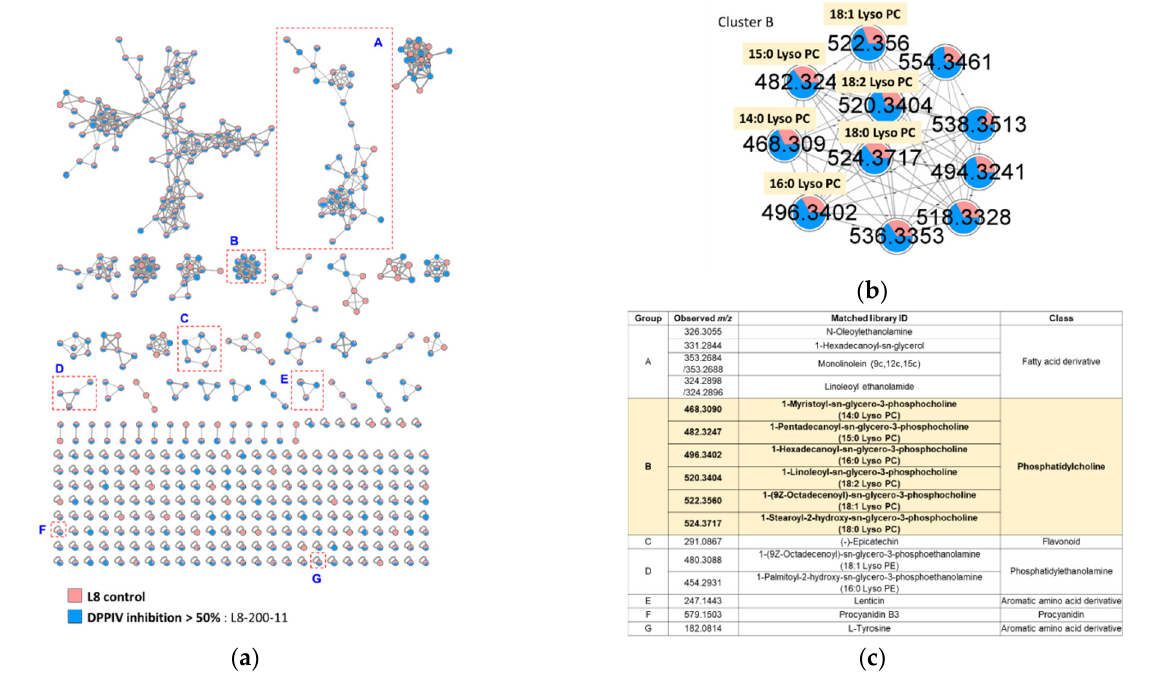
Figure 1. Feature-based molecular networking of lentil samples: ( a ) an entire molecular network of L8 control and L8-200-11 (most active sample); ( b ) targeted cluster annotation for the active lentil mutant lines extracts; ( c ) annotated molecular node by the comparison of Global Natural Product Social Molecular Networking library.